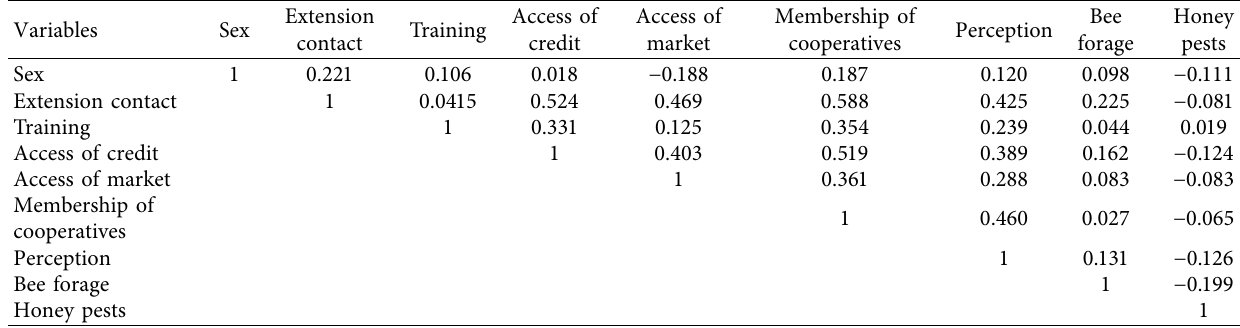
Table 20: Contingency coefficient for dummy variables.